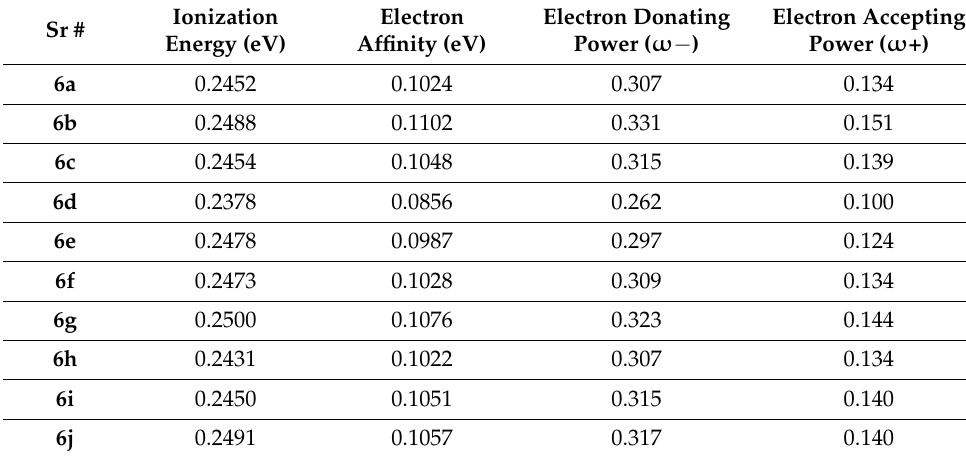
Table 3. Energetic parameters of synthesized derivatives ( 6a – j